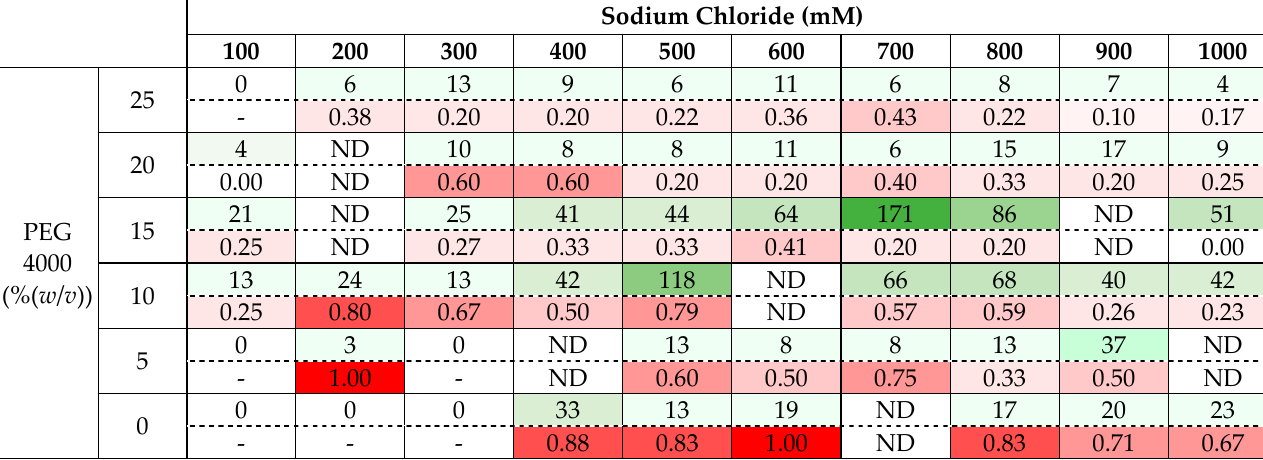
ND: No data. The color depth of the cell corresponds to the single crystal ratio (red) and the number of crystals